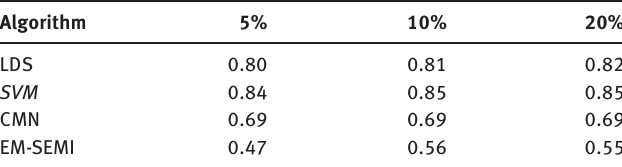
Table 2. Performance Results on KC2.